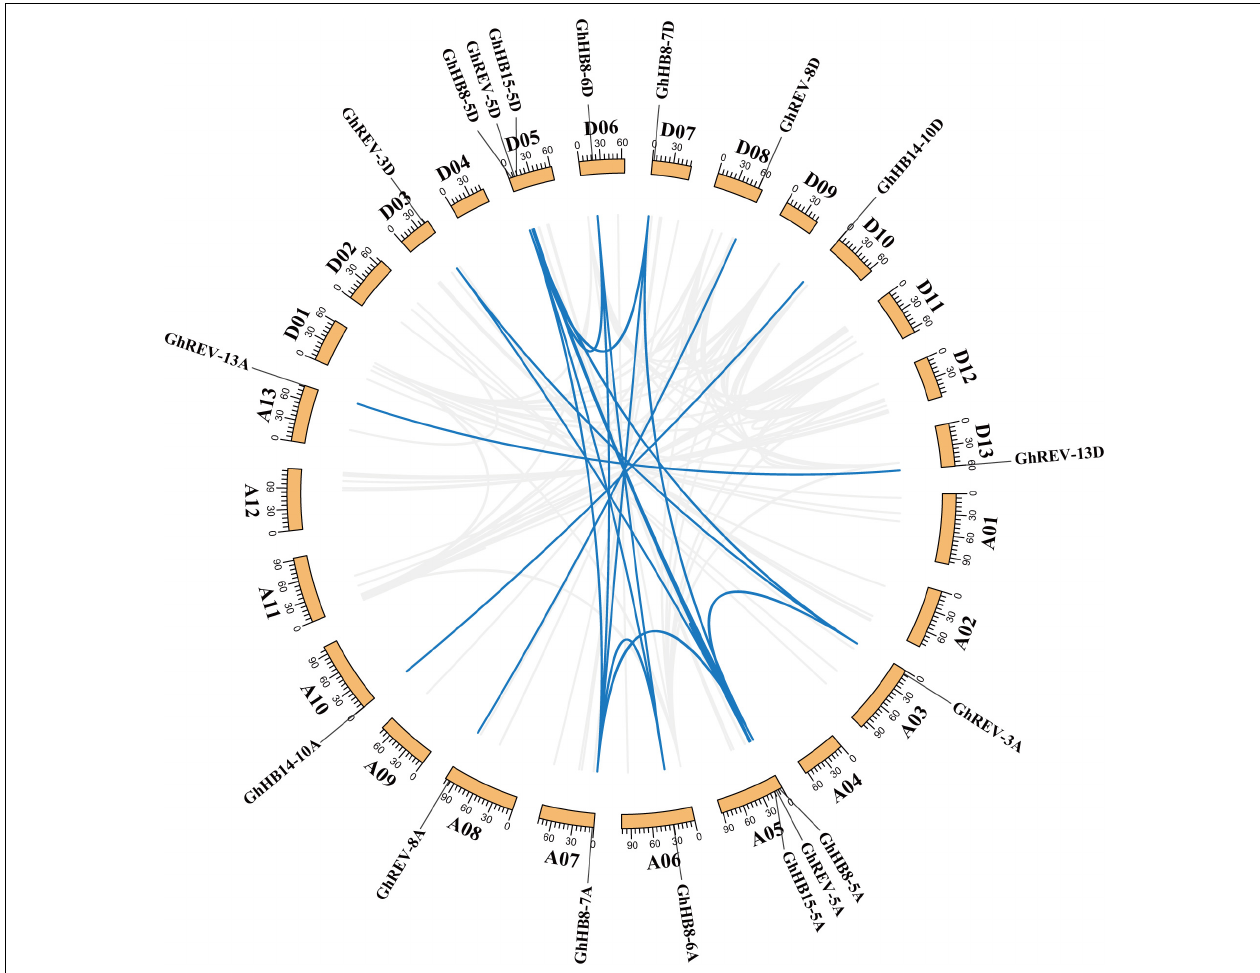
FIGURE 3 | Chromosomal distribution and gene duplication of HD-ZIP III genes in cotton ( Gossypium hirsutum ). The value on each chromosome represents chromosome length. Blue lines indicate duplicated HD-ZIP III gene